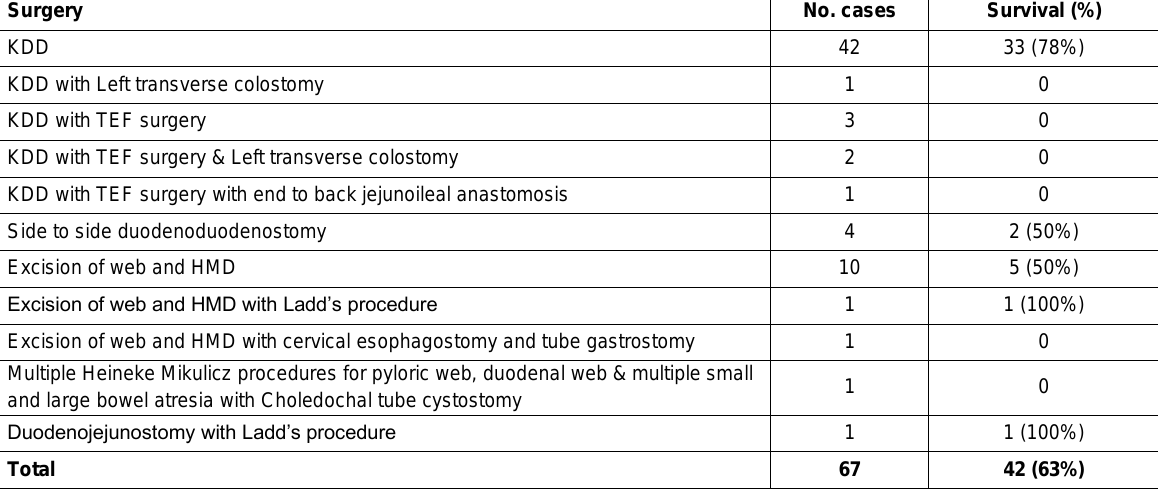
Table 3. Showing operative procedures performed for duodenal atresia as well as associated anomalies and outcome Surgery No. cases Survival (%) KDD 42 33 (78%) KDD with Left transverse colostomy 1 0 KDD with TEF surgery 3 0